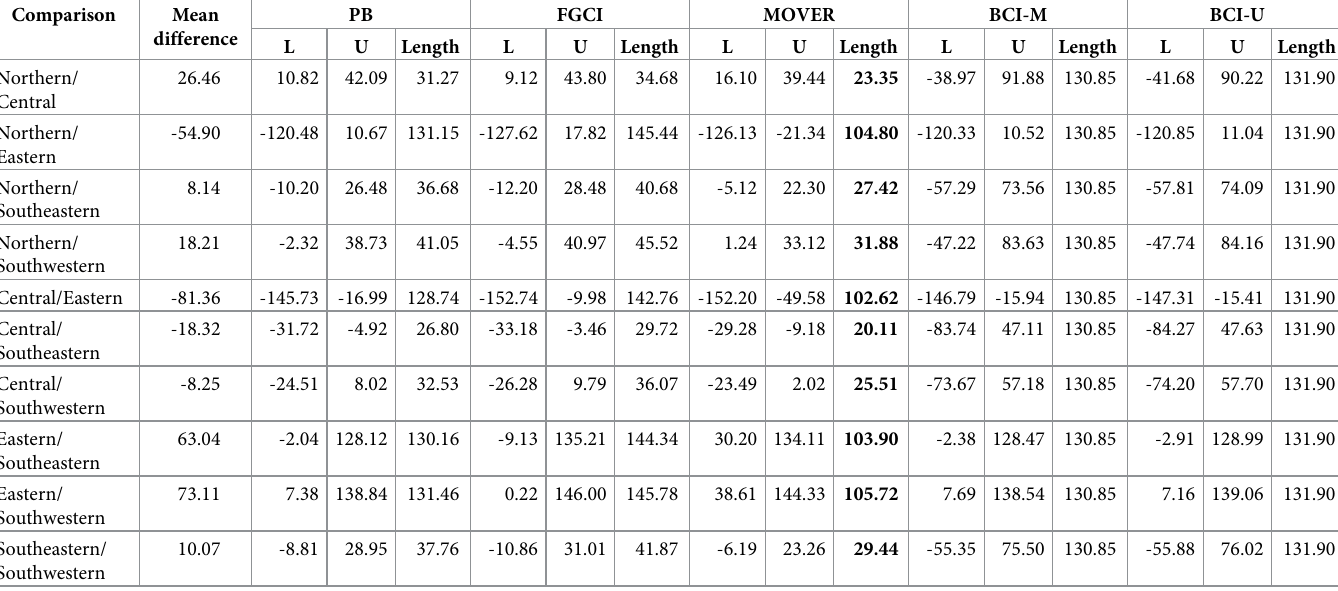
Table 6. 95%SCIs for all differences of weekly rainfall